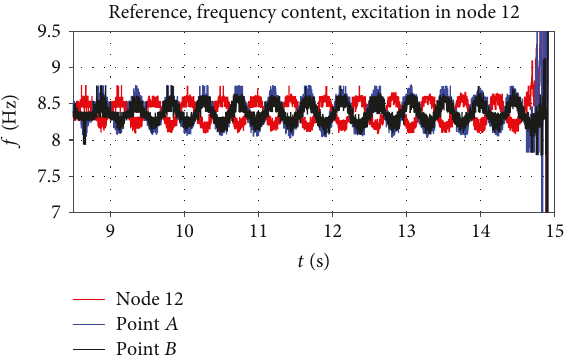
Figure 58: D2, maximum frequency, excitation near the damage.